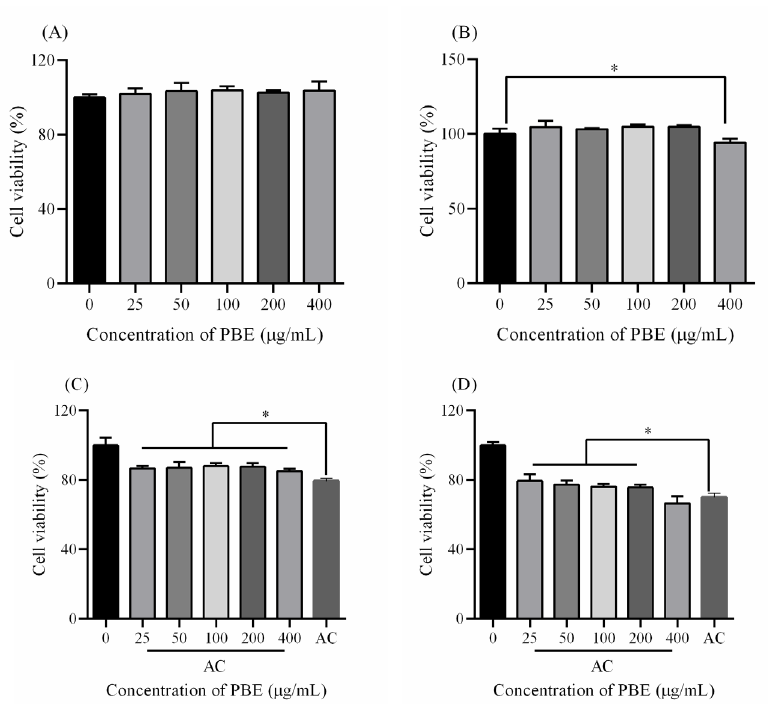
Figure 5. The toxicity of PBE on ( A ) Hep G2 cells and ( B ) HEK 293T cells. After treated with PBE for 24 h and exposed to AC for 10 h, the cell viability of ( C ) Hep G2 cells and ( D ) HEK 293T cells. Note: * means p < 0.05.